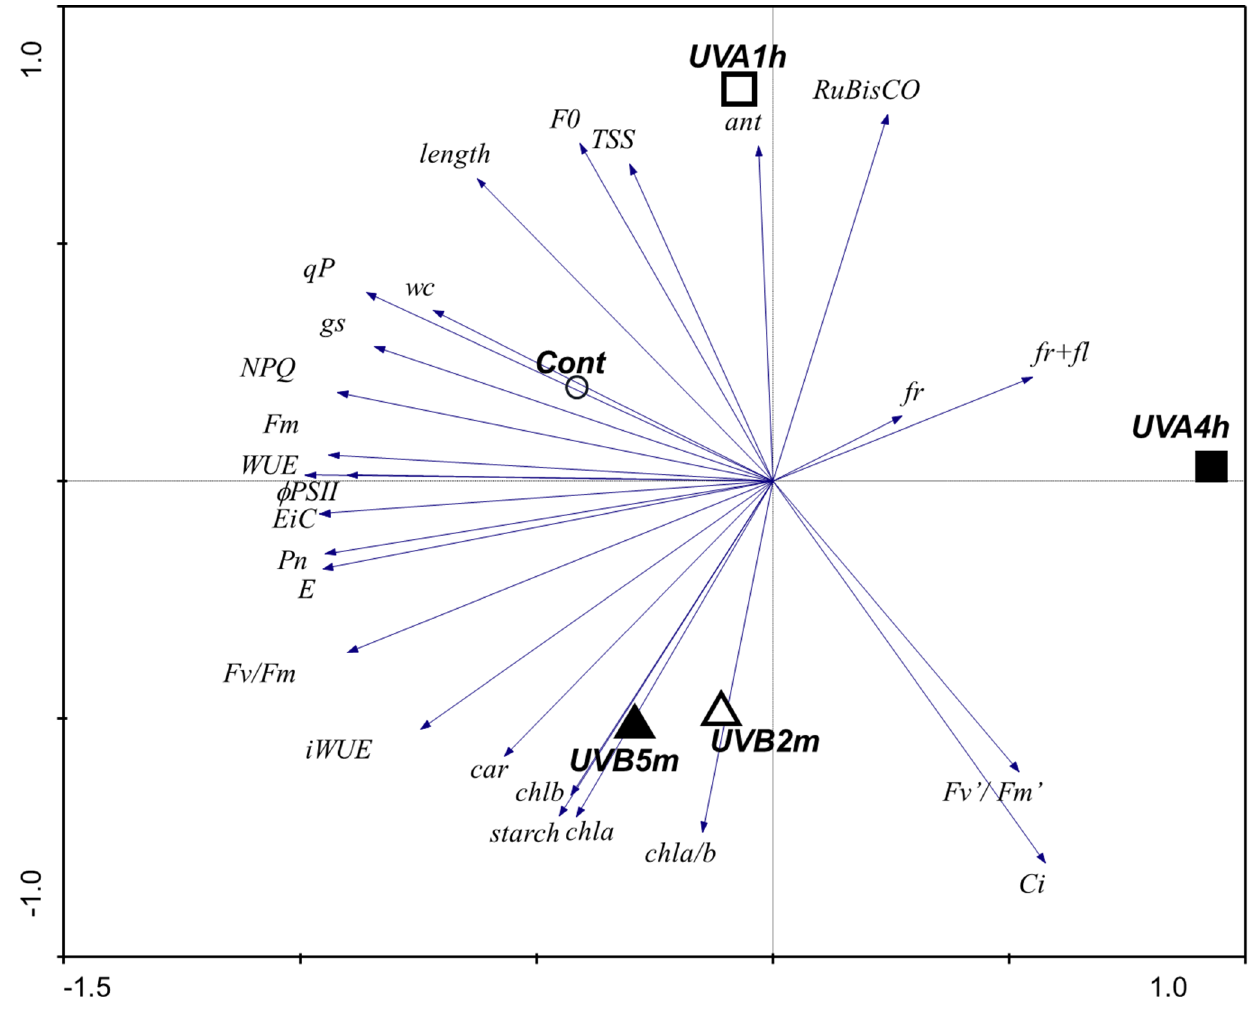
Figure 5. PCA analysis of functional responses of tomato fruit plants exposed to UV-A (1 and 4 h) and to UV-B (2 and 5 min) for 30 d.